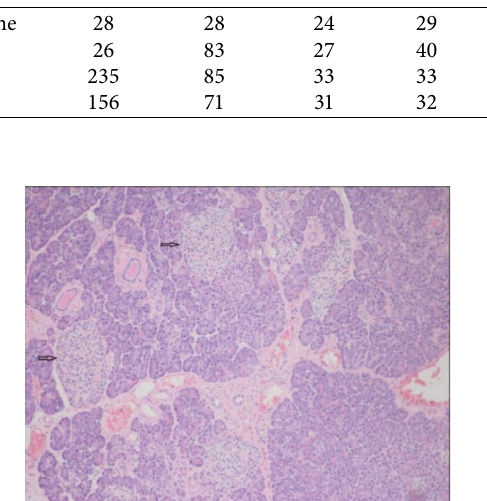
Figure 1: Pancreatic parenchyma at 100 × magnification, with arrows indicating enlarged islets.